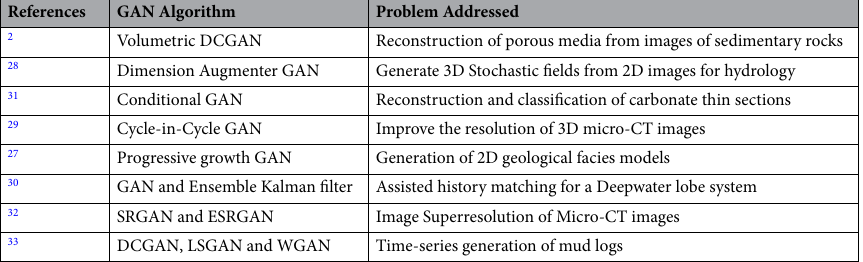
Table 1. Applications of GANs for geological data